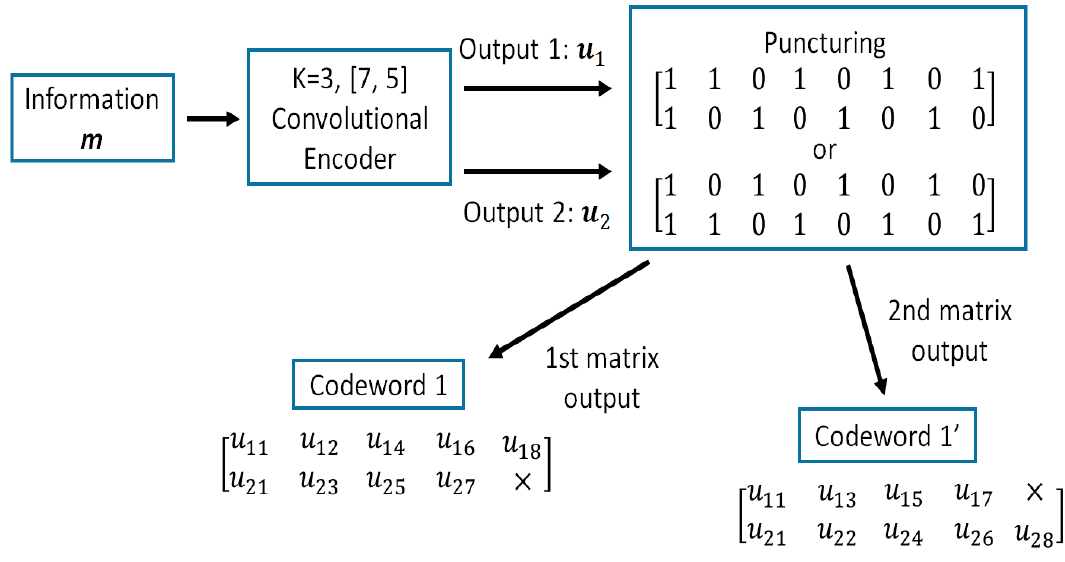
Figure 3. Punctured convolutional codes (cid:1870) (cid:3030) = 8/9 .